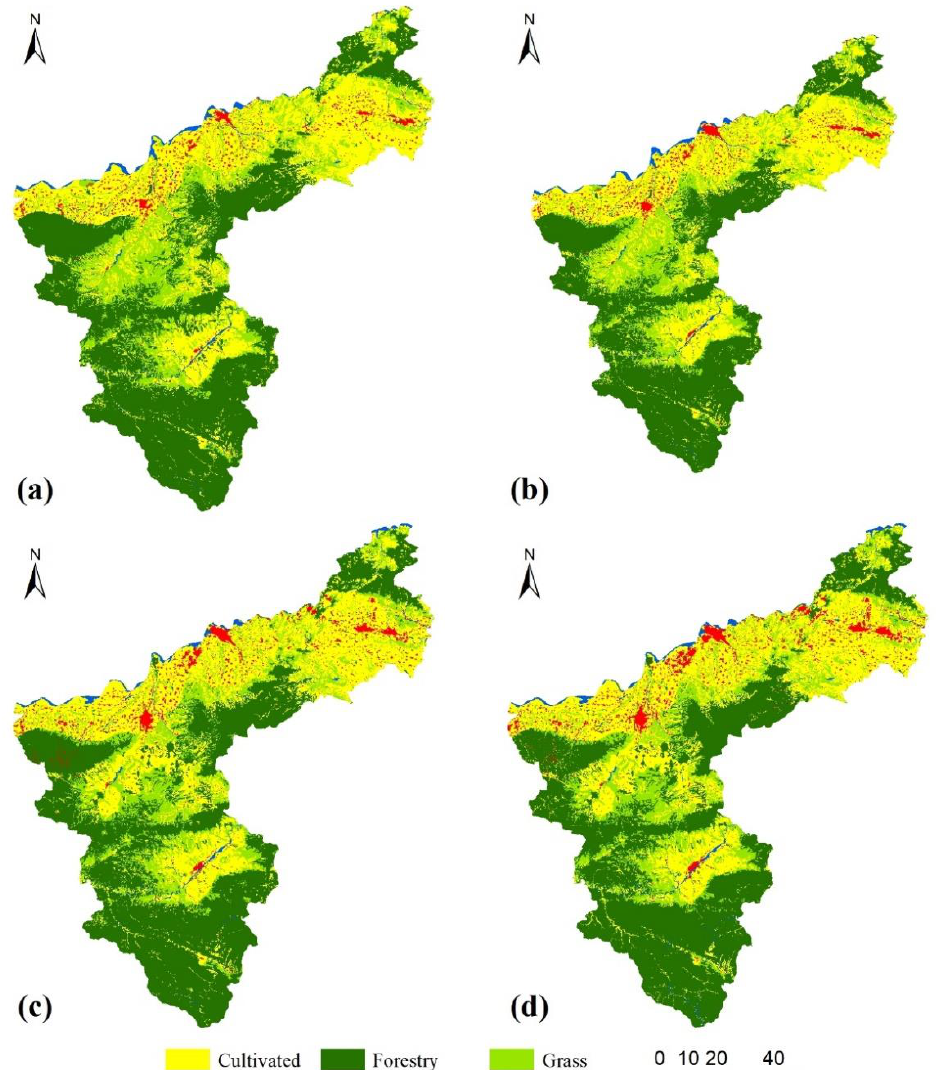
Figure 6. Spatial distribution of land use in Sanmenxia (( a ), 1990; ( b ), 2000; ( c ), 2010; ( d ), 2020).